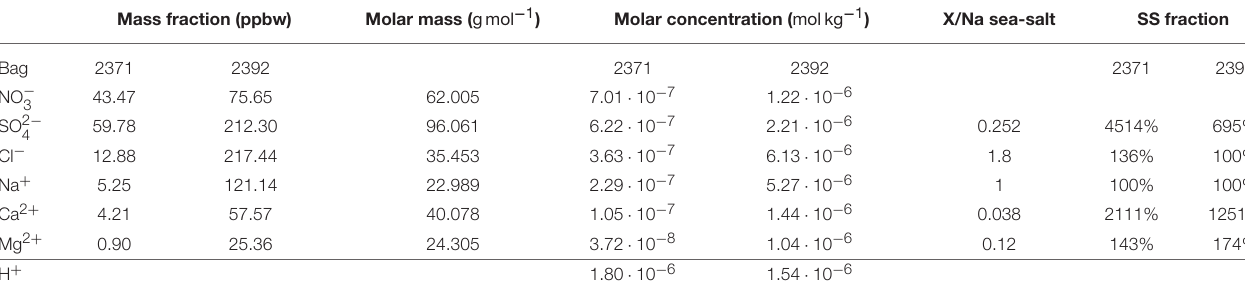
TABLE 2 | Mean IC concentrations within two one-meter-long ice core segments (bags) which envelope the studied